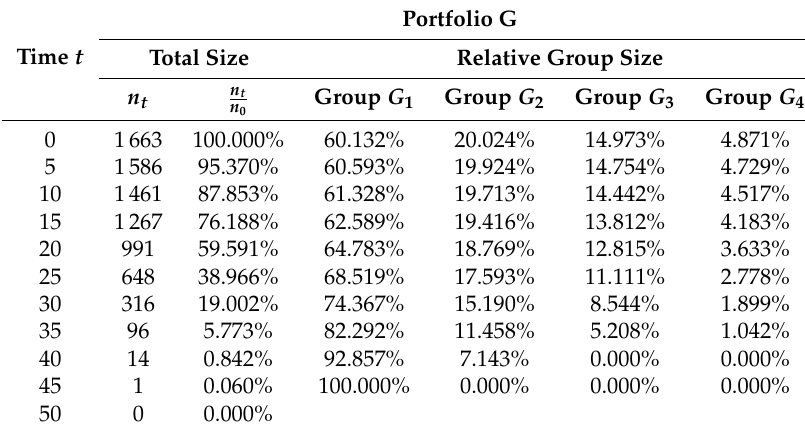
Table 17. Portfolio G: portfolio size and